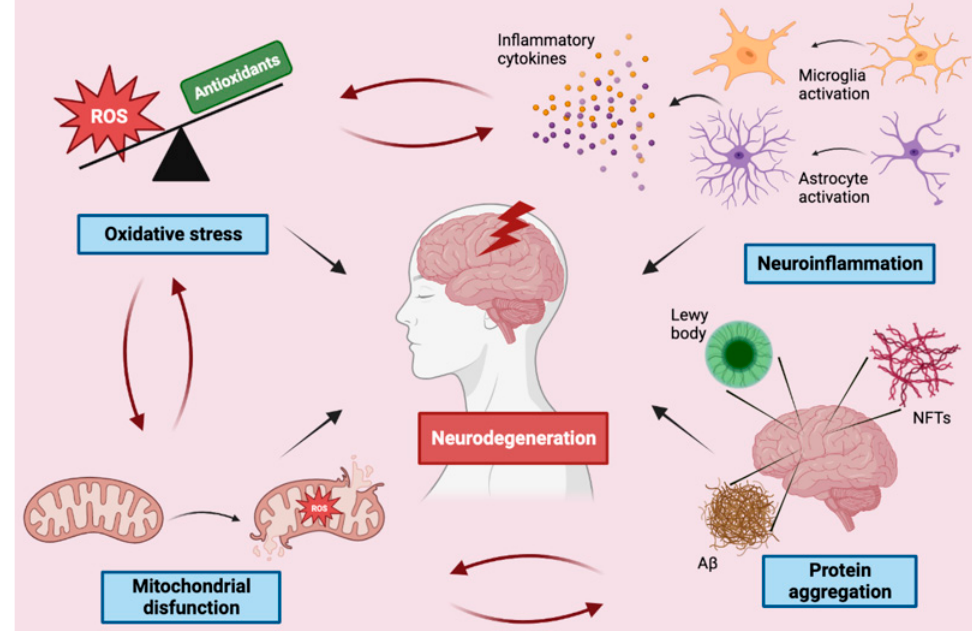
Figure 1. Schematic representation of the main mechanisms involved in neurodegeneration. ROS—reactive oxygen species, NFTs—neurofibrillary tangles.